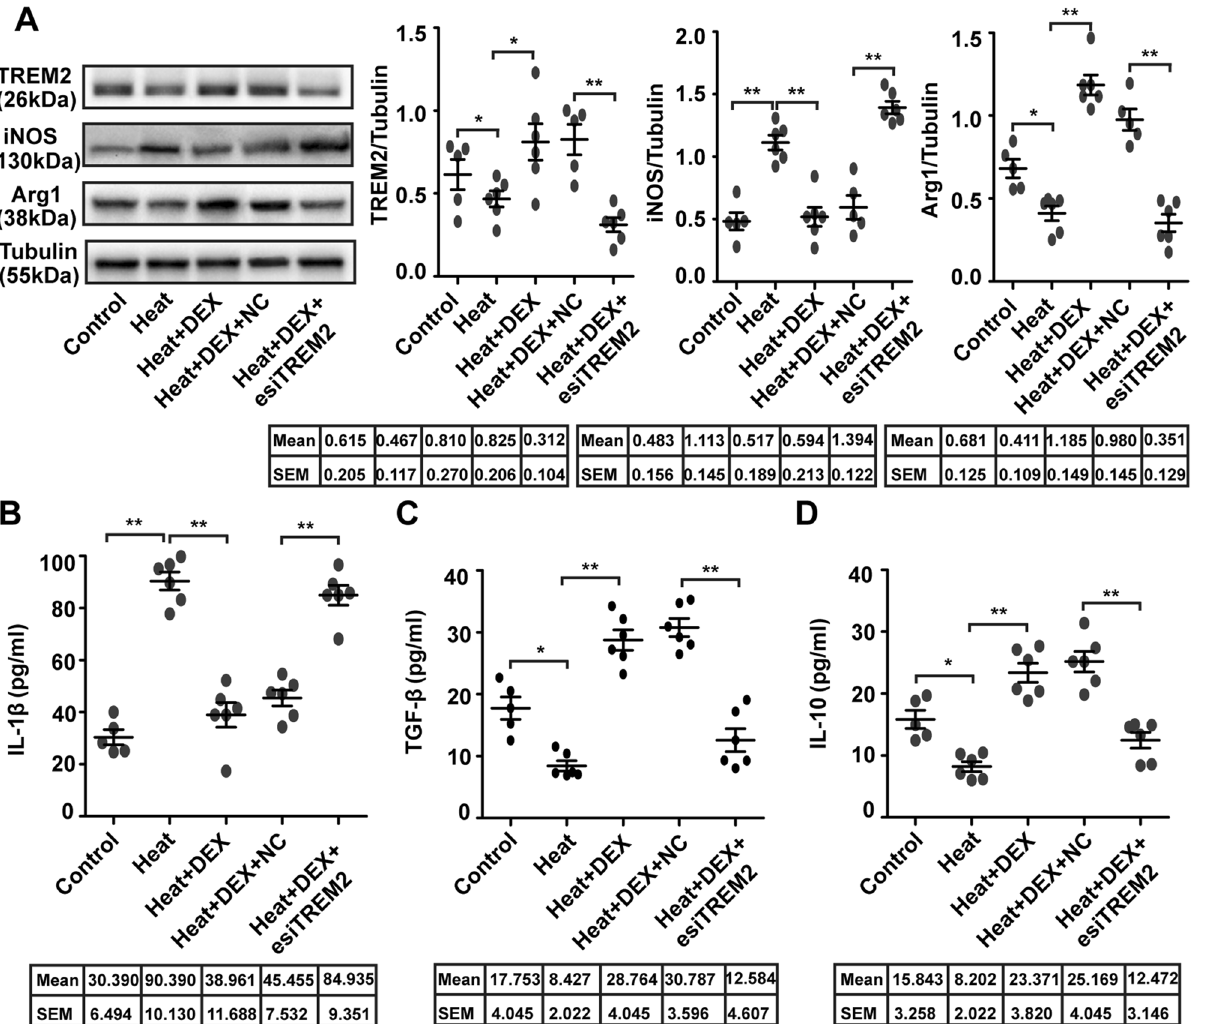
Figure 4. Effects of TREM2 esiRNA on microglial activation. BV-2 cells were pretreated with or without DEX (16 µg/ml) and TREM2 esiRNA (50 nM), and then subjected to heat exposure at 42 °C for 2 h, followed by a 6-h recovery period at 37 °C. ( A ) The protein expression of iNOS and Arg1 was determined by Western blotting. ( B – D ) The expression of IL-1β, TGF-β and IL-10 was detected by ELISA. The data are shown as the mean ± SEM of three independent experiments. Statistical analysis: Two-way